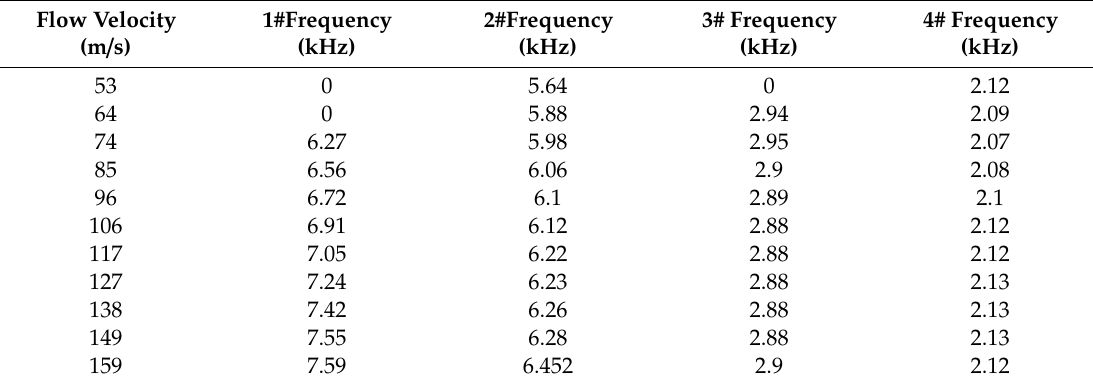
tested by the same test method and are recorded in Table 2. Table 2. Sound pressure parameters at the bottom of the resonant